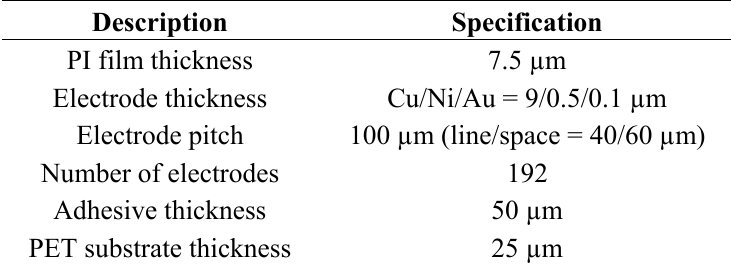
Table 1. Specifications of the film-type connector.